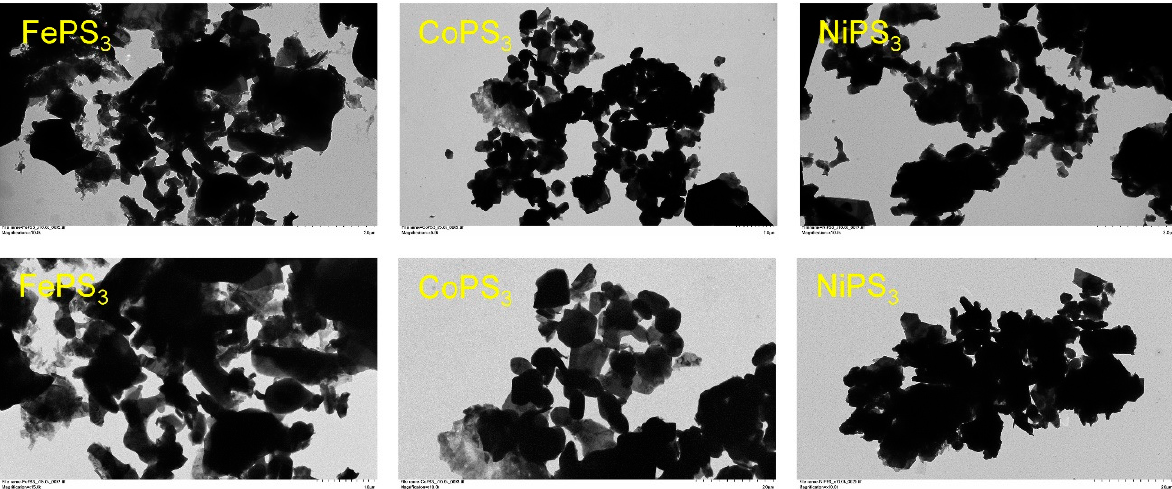
Figure 5. SEM images of M-P-S materials synthesized from metal halides and (P 2 S 5 + P) at 500 °C. The right images are higher magnification images of the products shown in the left images.